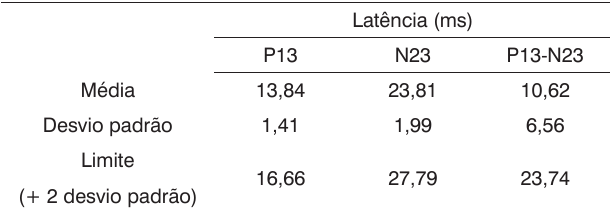
Tabela 4. Valores de referências para o parâmetro latência do VEMP, independente do